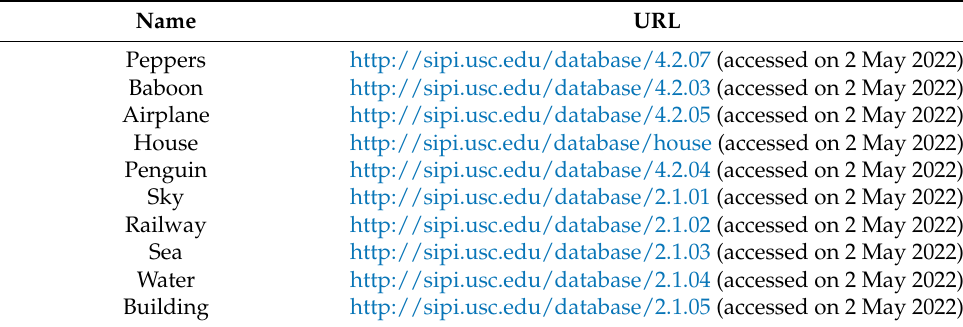
Table 2. The URL of the plain